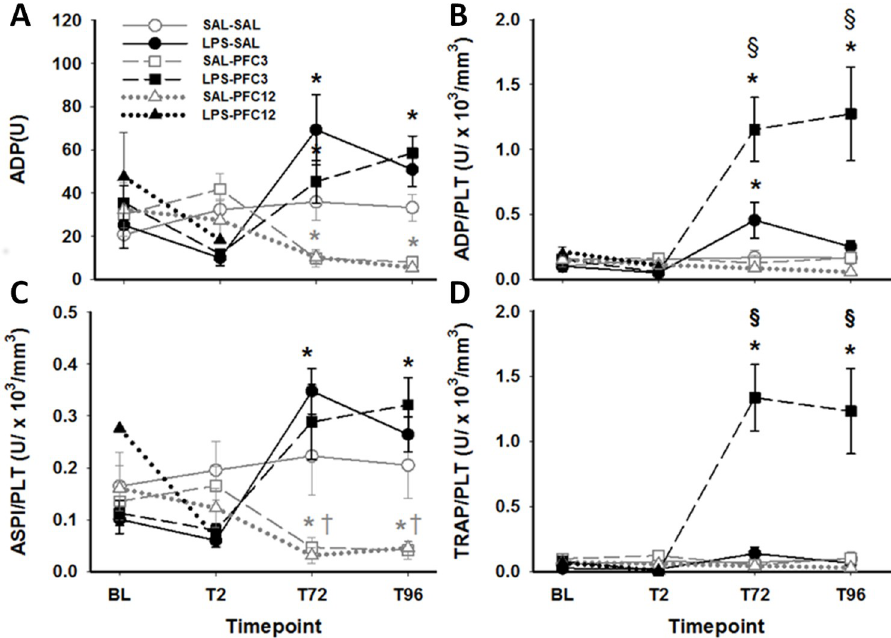
Fig 4. Platelets were inhibited by PFC administration and activated in response to LPS. A. Platelet aggregation in response to ADP. B. ADP aggregation normalized to platelet count C. ASPI aggregation normalized to platelet count. D. TRAP aggregation normalized to platelet count. Open or closed symbols depict initial infusion conditions with open for saline and closed for LPS. Symbol type depicts second infusion treatment with squares, circles and triangles for saline, PFC3 and PFC12, respectively. Data that are significantly different, p < 0.05, are shown compared to: baseline, by � ; to SAL-SAL (SAL-PFC groups only), by †; and to LPS-SAL (LPS-PFC groups only), by §.